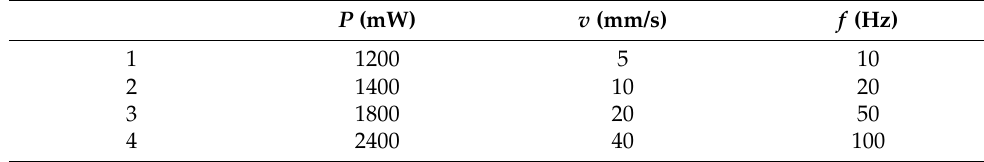
Table 2. The setting of heat laser parameters and thermal image acquisition parameters.